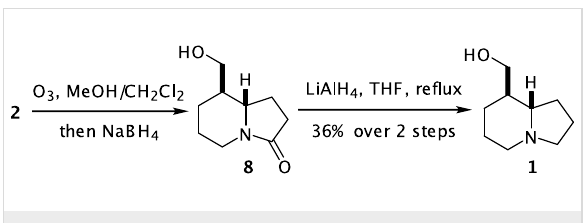
then subjected to asymmetric reduction with